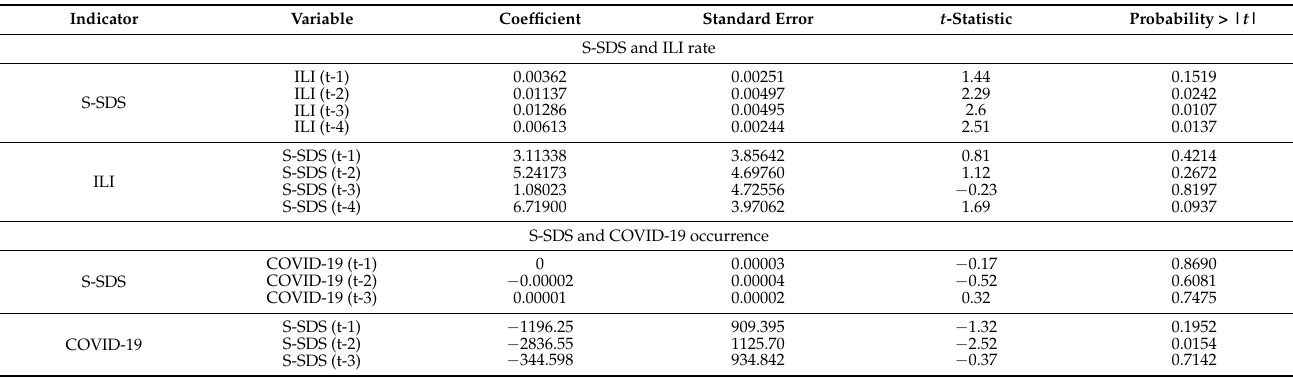
Table 1. Dynamic relationship (vector autoregressive model) between subway use-based social distancing score and influenza-like illness/coronavirus disease